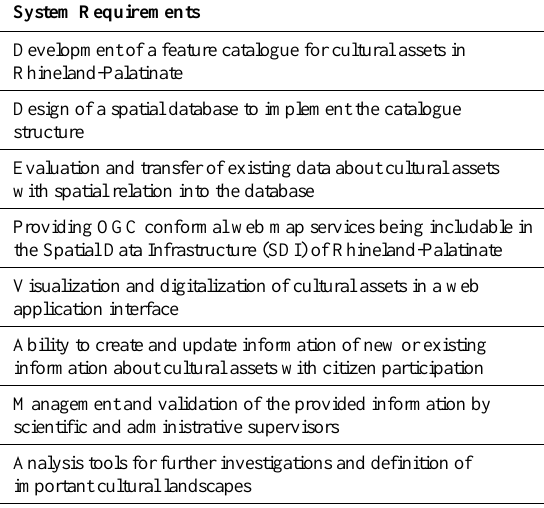
Table 1. System requirement definition.